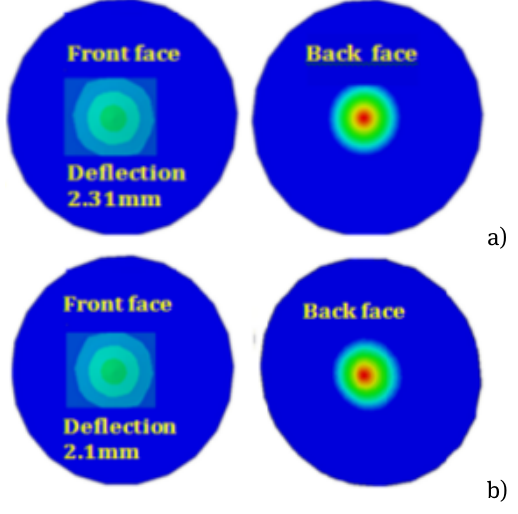
Figure 17: 24-Ply specimens under a) flat and b) round nose im-